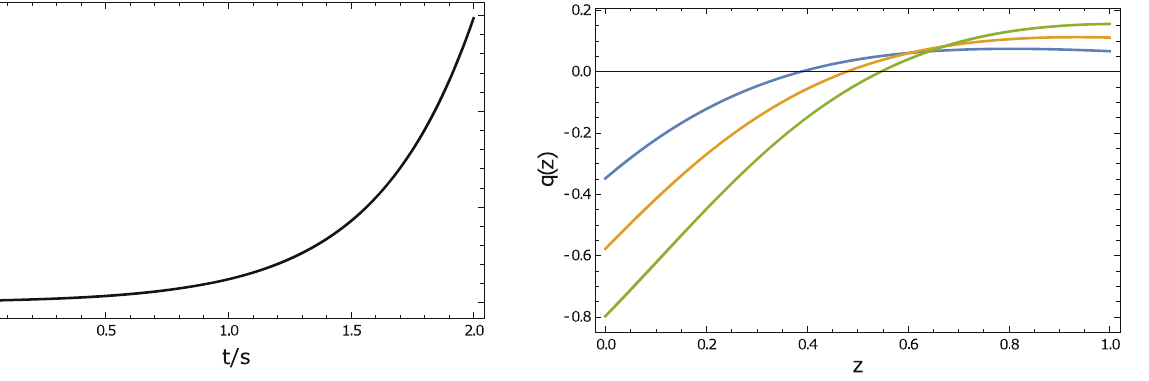
Fig. 4 Scale factor as a function of cosmic time for jerk parameter in Eq. (48); m >> n , s = 1, p = 0 . 5